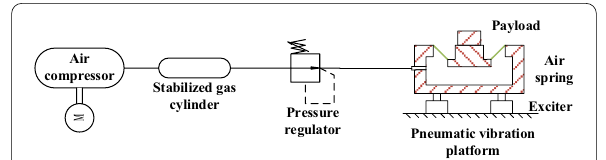
Figure 4 Vibration isolation schematic of a pneumatic pressure regulator